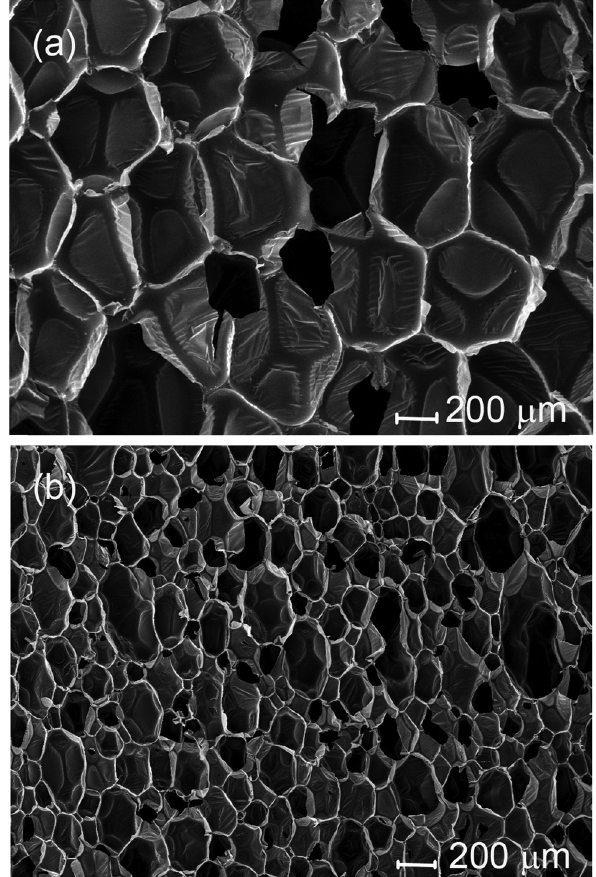
Figure 3: Cross - section of pouring ( a ) and spray ( b ) foam blocks in the foam rise direction at SEM 100 × magni fi